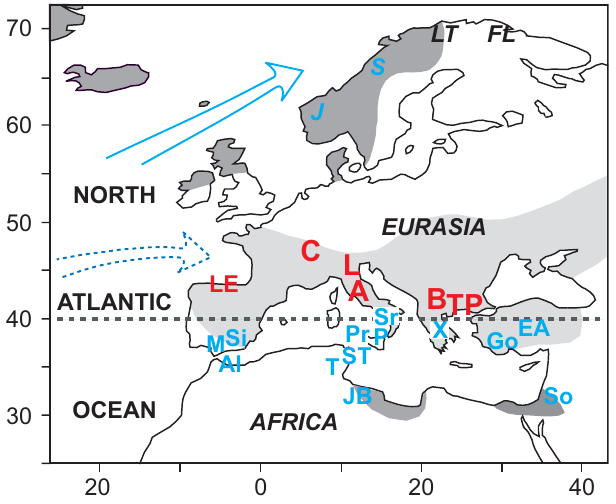
Fig. 8. Positive NAO-like palaeohydrological/palaeoclimatic pat- tern during the Holocene climatic optimum as suggested by milder (black letters) and wetter (blue letters) versus drier (red letters) cli- matic conditions around the Mediterranean Basin and in